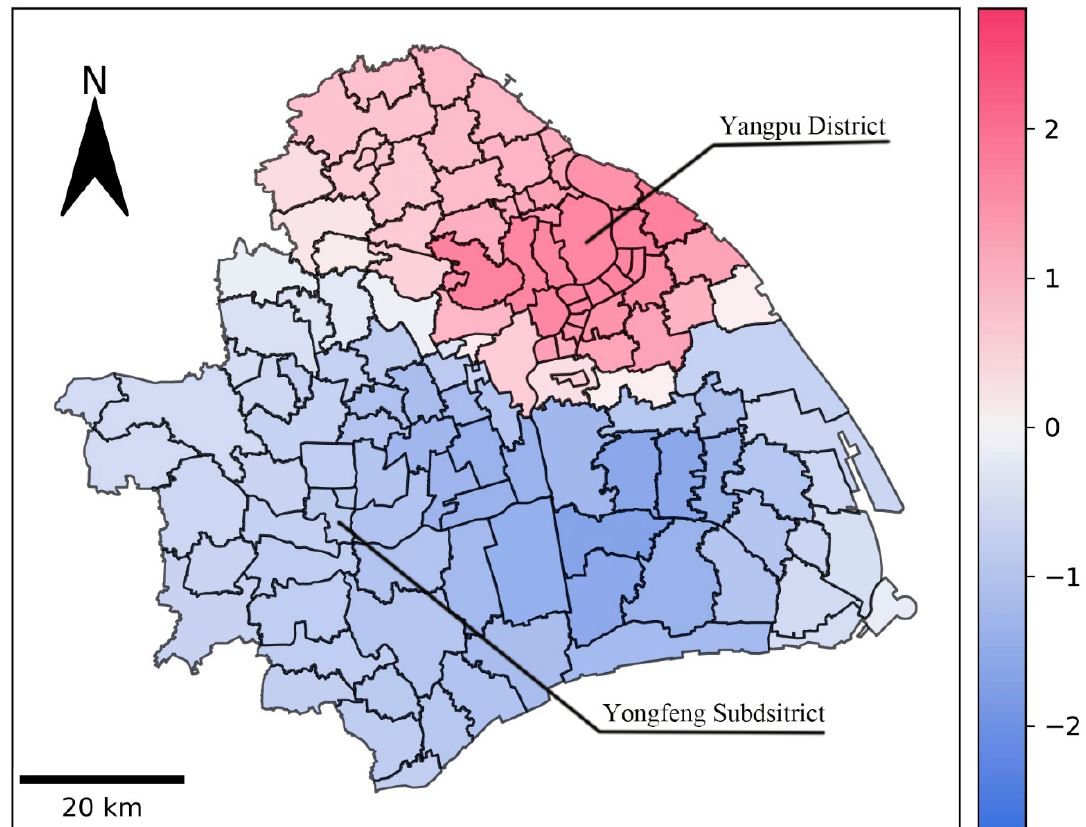
Figure 7. The surface of the regression coefficients of the location factors in the MGWR model.